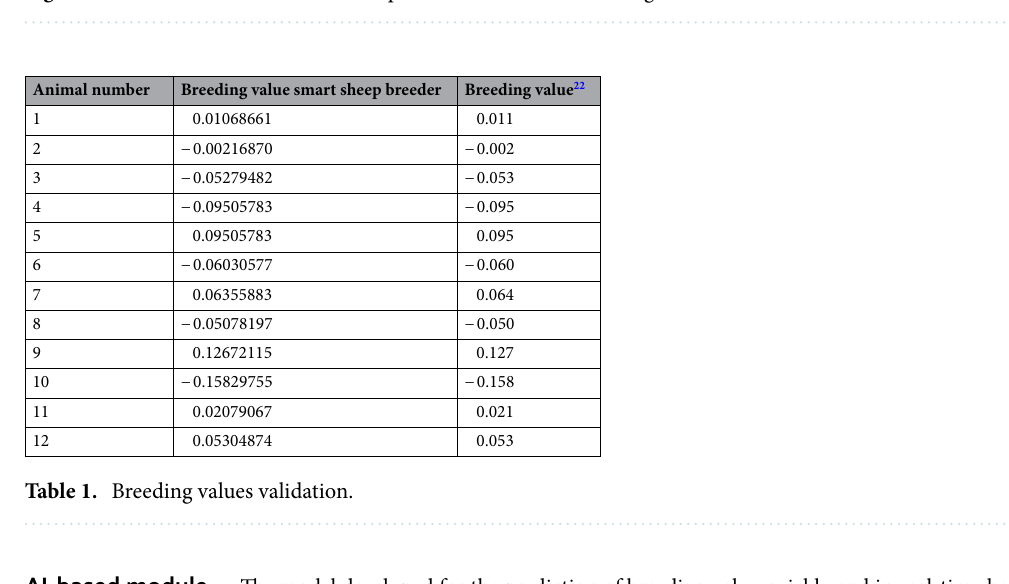
Figure 5. Correlation between true and predicted values for the AI algorithm.